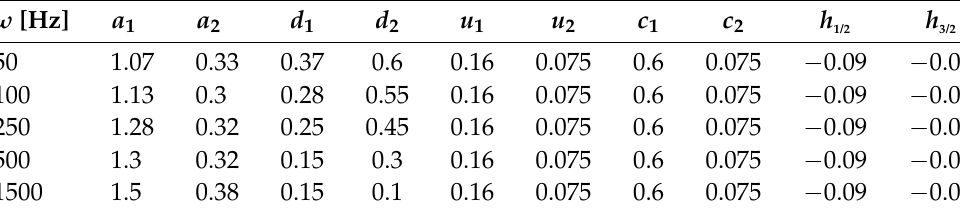
Table 2. Values of the ‘ h ’-field and all ac field parameters entering (12) used to describe the ac susceptibility behavior of the compound Na 9 [Er(W 5 O 18 ) 2 ] depicted in Figures 8 and 9. The first column lists the frequencies of the alternating magnetic field at which all parameters are